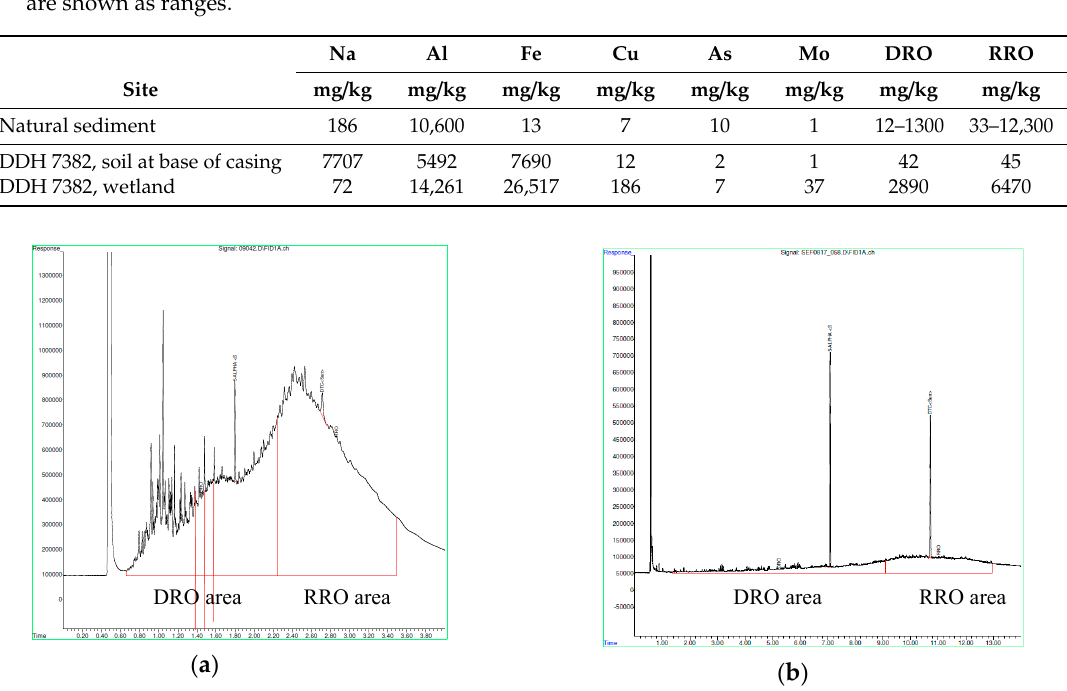
Figure 7. DDH 7382, petroleum. ( a ) The wetland sediment sample has the classic “porcupine” profile of diesel (“DRO area”), and the classic “lump” profile for lube oil (which could also represent material from drilling mud) on the left. ( b ) The chromatogram for wetland water does not show evidence of petroleum. The two large peaks in the pictures are from laboratory tracers. The chromatogram for the sample of material from the base of the casing was similar.